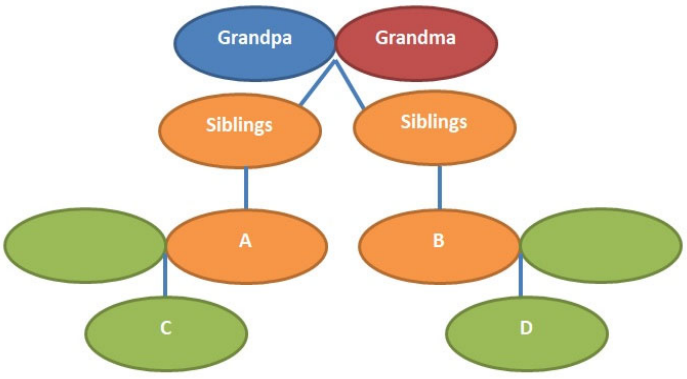
Figure 1. First cousins: A and B, second cousins: C and D.